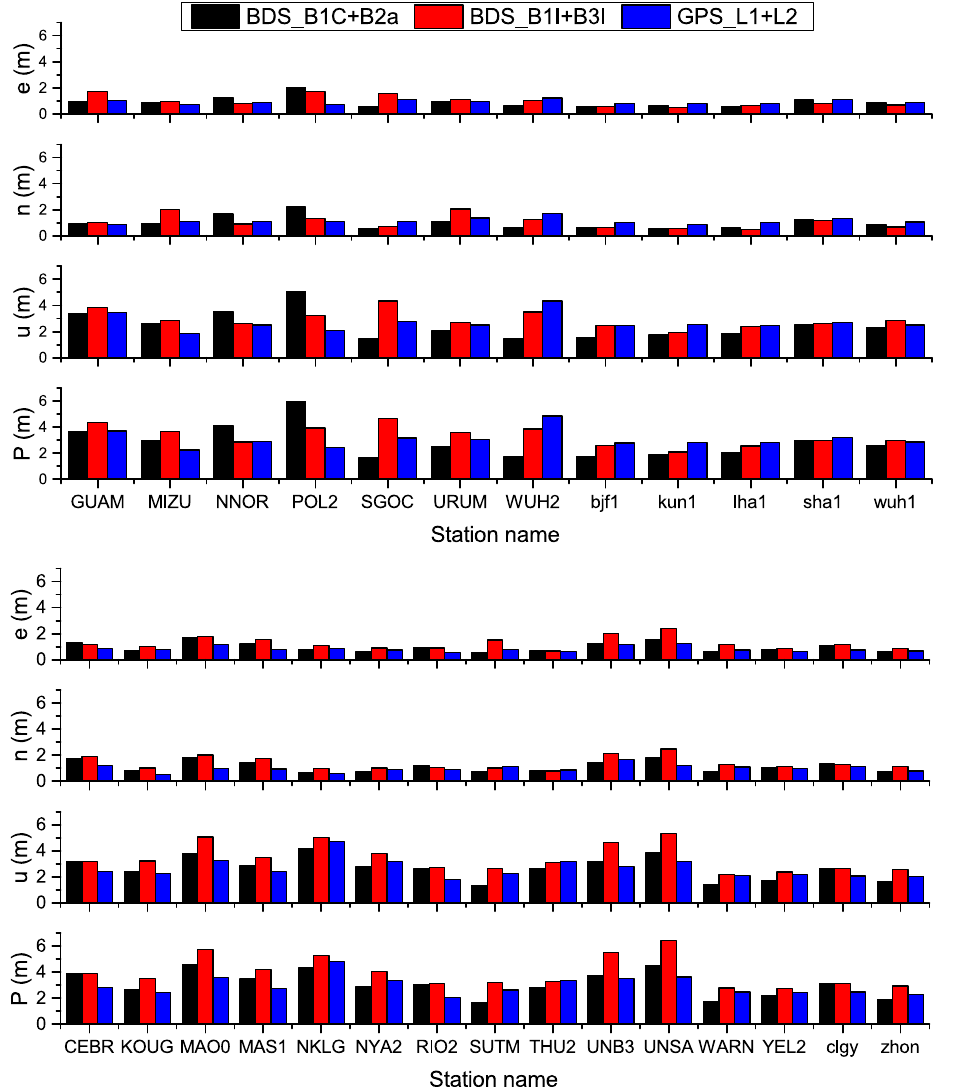
Figure 9. RMS statistics of dual-frequency SPP positioning errors for stations in the Asian-Pacific region (top) and other regions (bottom). The MGEX station names are in the capital letters and the iGMAS station names are in the lowercase